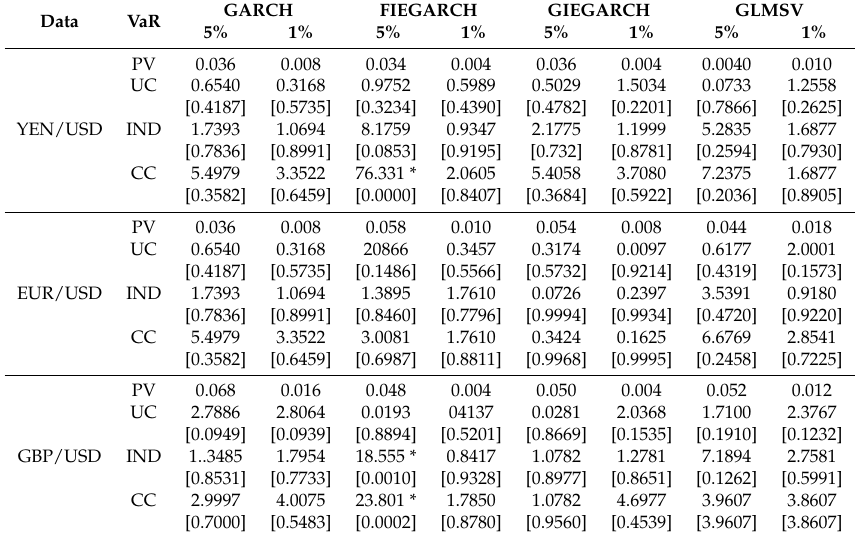
Table 8. Backtesting VaR Thresholds for One-Step-Ahead